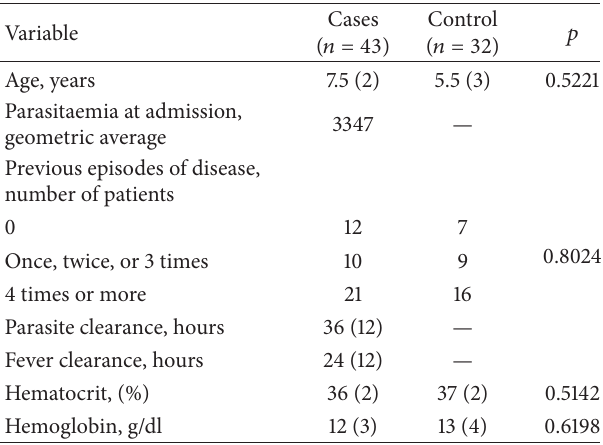
Table 1: Baseline characteristics of